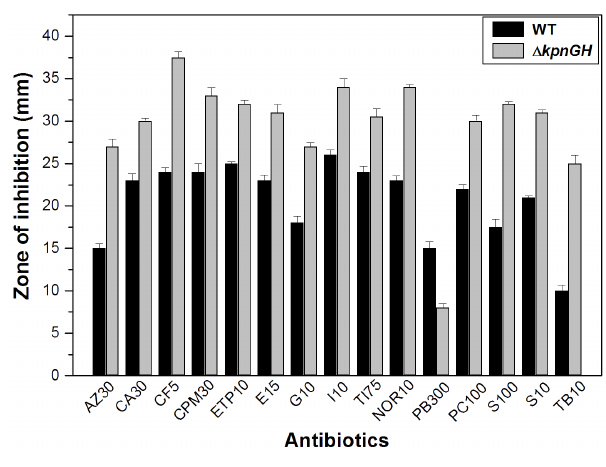
Figure 3. Antimicrobial Susceptibility assays. The Kirby Bauer disc diffusion assay was performed with different antibiotics using commercial discs. Data for representative drugs have been shown here.